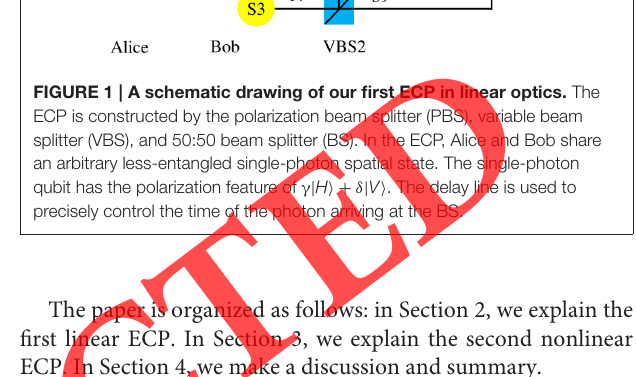
H δ V . The delay line is used to | i + | i